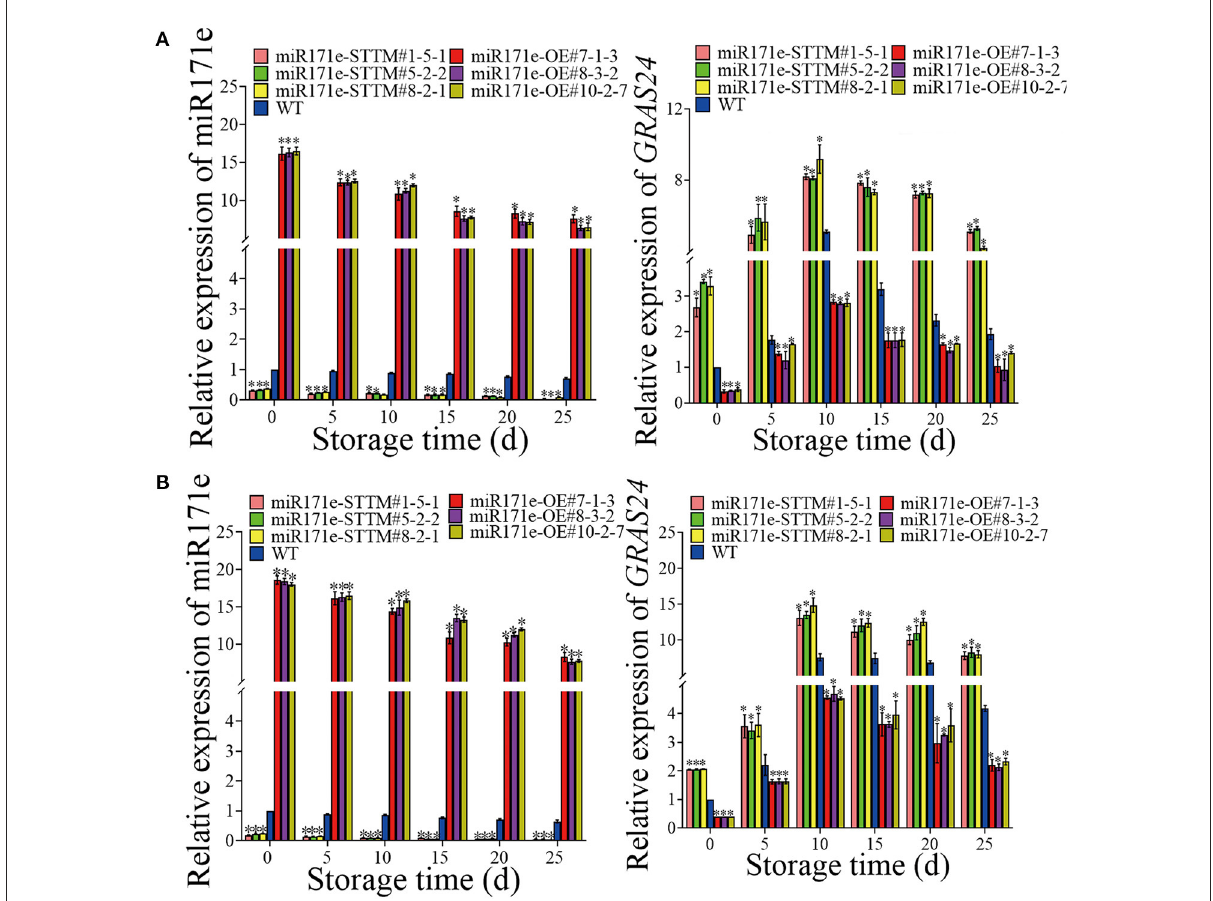
FIGURE5 The relative expression of Sly-miR171e, GRAS24 in tomato fruit at MR (A) and MG stage (B) . Vertical bars represent standard deviations of the means, n = 3. Asterisks indicate the statistical difference in the significance at * p < 0.05.